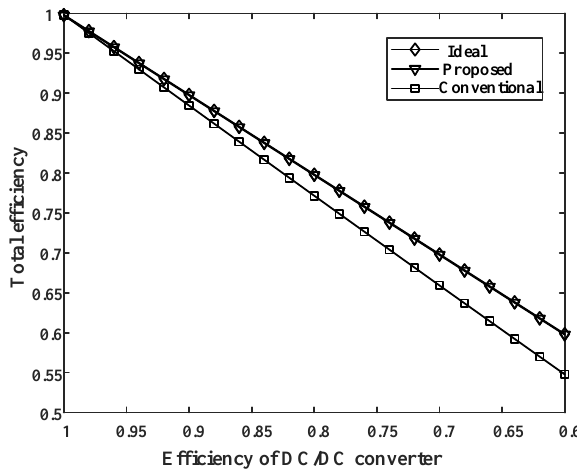
Figure 11. The total efficiency versus the efficiency of converter η .